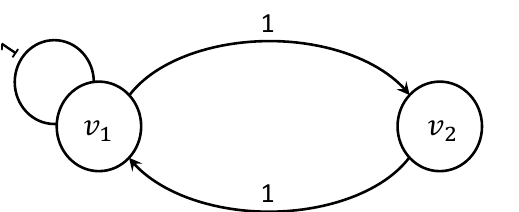
Figure 1. The weighted graph determining the considered resource